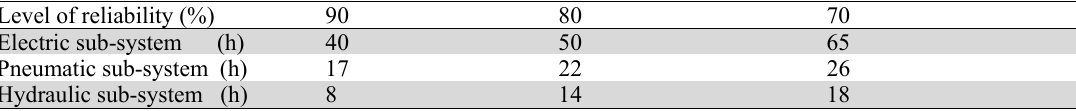
Reliability-based PMI for PWM